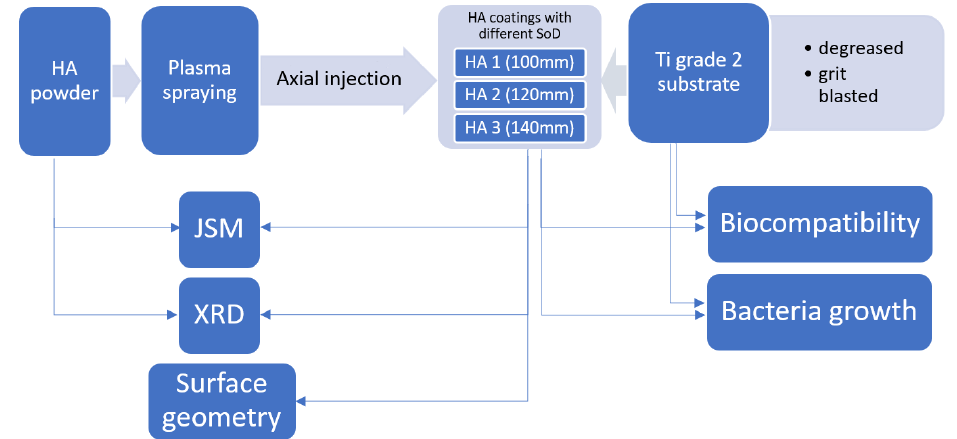
Figure 1. Workflow of the experiment.